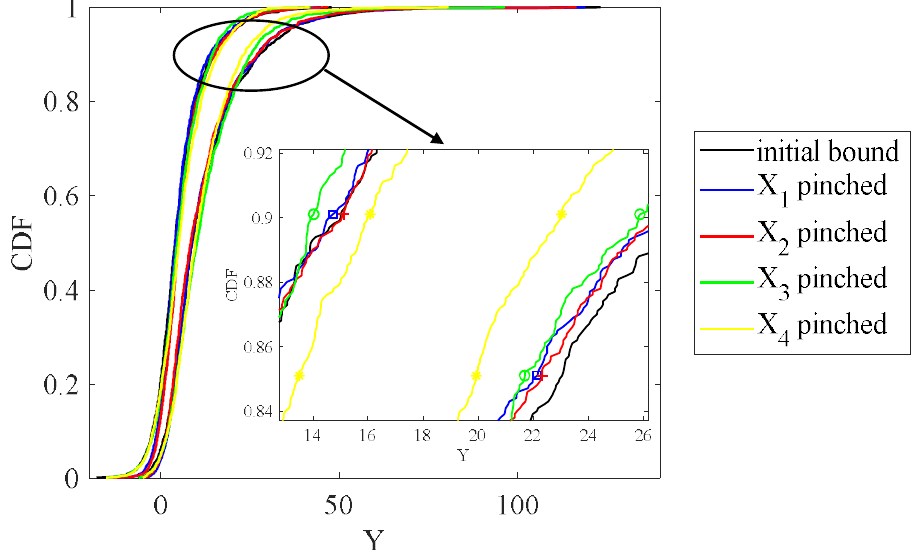
Figure 12. P−boxes for the system analytical function with diverse independent inputs pinched after affine transformation.